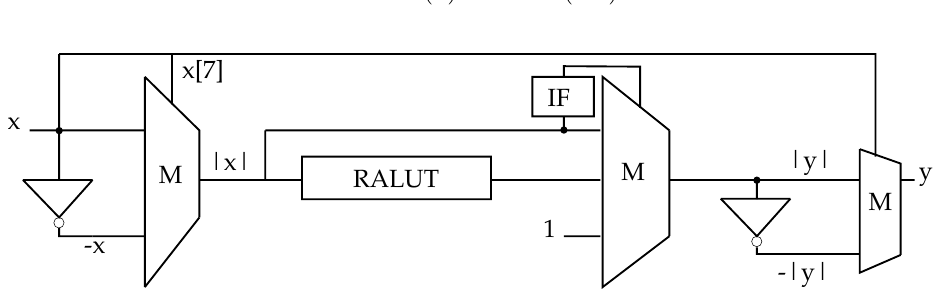
Figure 2. Schematic of the hardware that approximates the tanh-function. Due to the symmetry, the result is calculated for the absolute